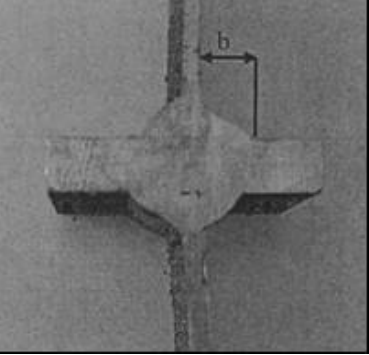
Figura 3: Geometria dei provini – sezione